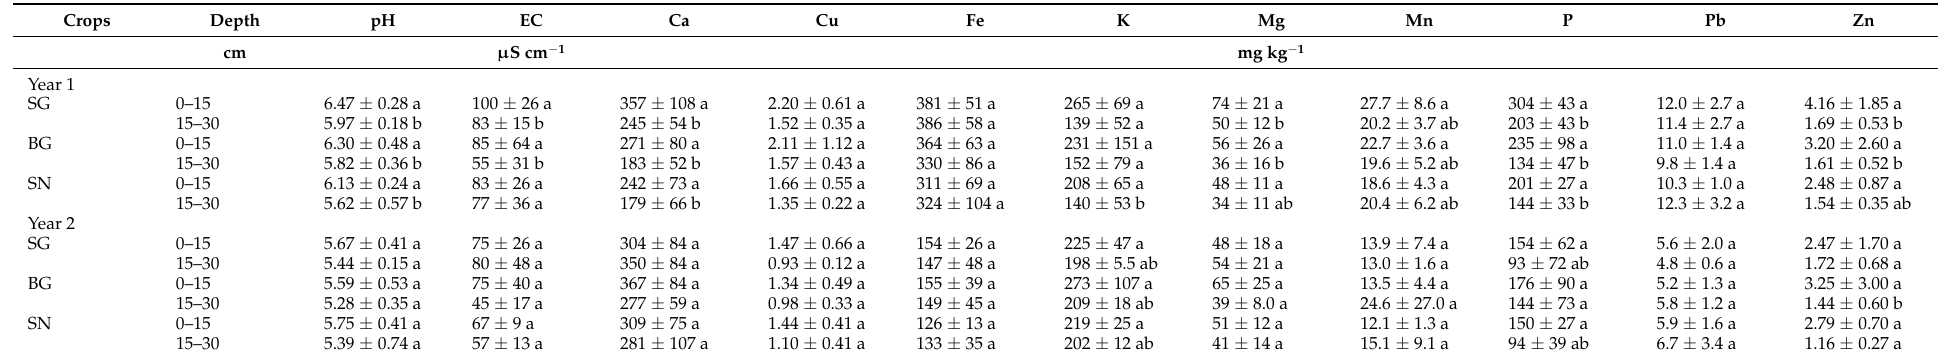
Table 8. Soil pH, EC, nutrient and metal concentrations on soil depth from switchgrass (SG), bermudagrass (BG) and stinging nettle (SN) plots for the first and second